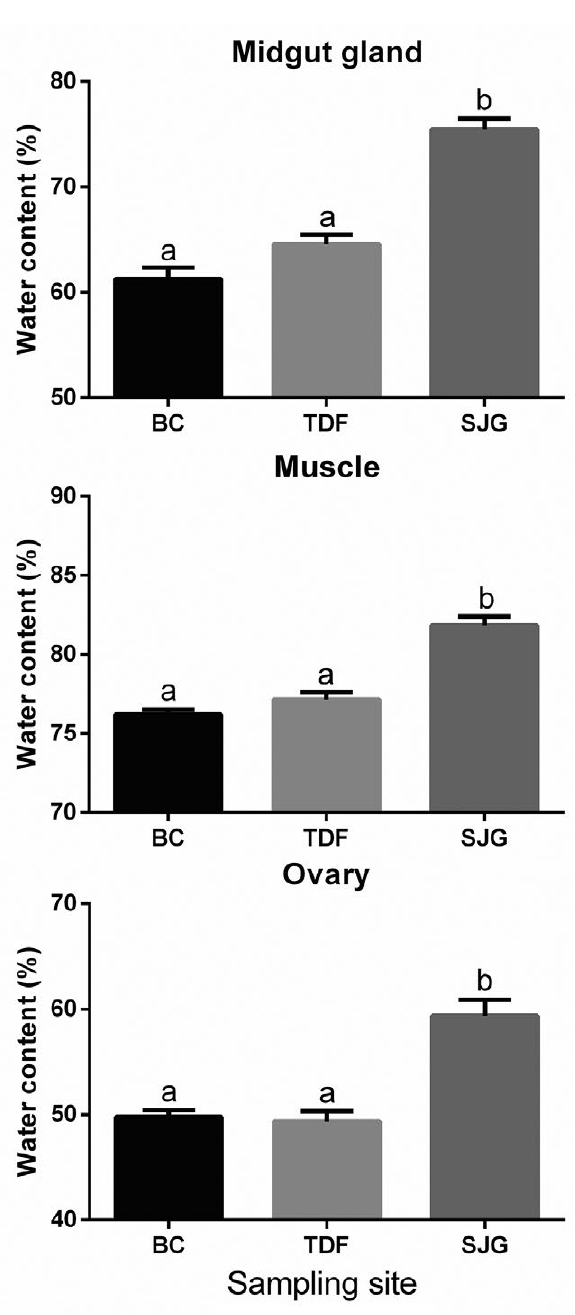
Fig. 3. – Water content (mean±SE) in midgut gland, muscle and ovary of L. santolla from the three sampling sites: Beagle Channel (BC), Tierra del Fuego (TDF) and San Jorge Gulf (SJG). Different letters indicate significant differences between sites (ANOVA and Tukey, p<0.05; or Kruskal Wallis and Dunn,